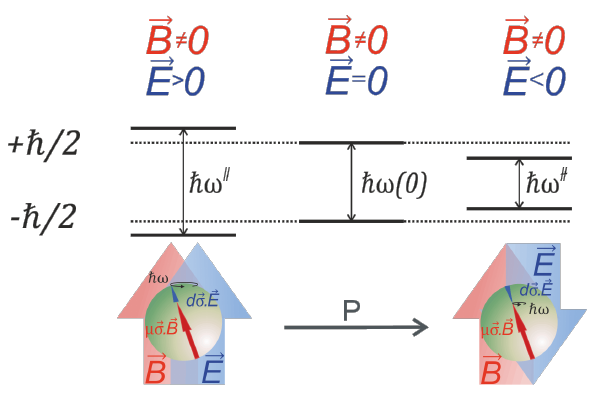
Figure 3. Relative level splitting due to the interaction of the electric dipole moment with an applied electric field. The cartoon illustrates the equivalence of a parity inversion with the inversion of the electric field. Parity inversion changes the Hamiltonian and eigenstates of the system manifesting parity